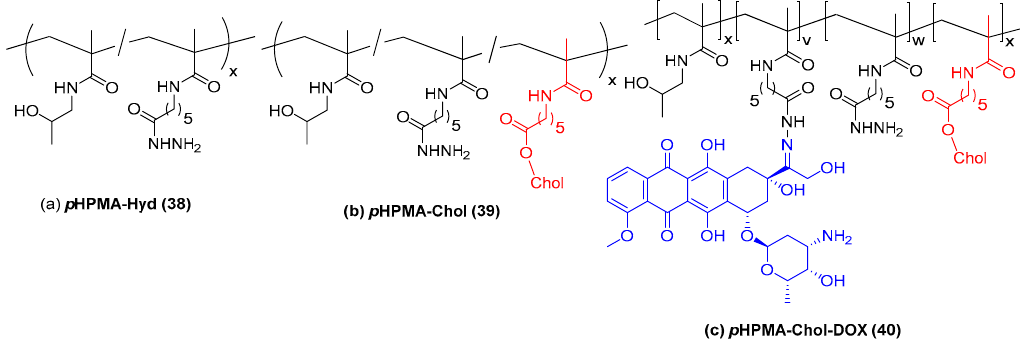
Figure 3. Schematic structures of a ) cholesterol-free p HPMA-based copolymers ( p HPMA-Hyd ) bearing hydrazide groups; b ) statistical cholesterol-containing ( p HPMA-Chol ) groups distributed along the polymer chain; and c ) cholesterol-containing p HPMA-based copolymers carrying the anticancer drug doxorubicin (DOX) ( p HPMA-Chol-DOX ).